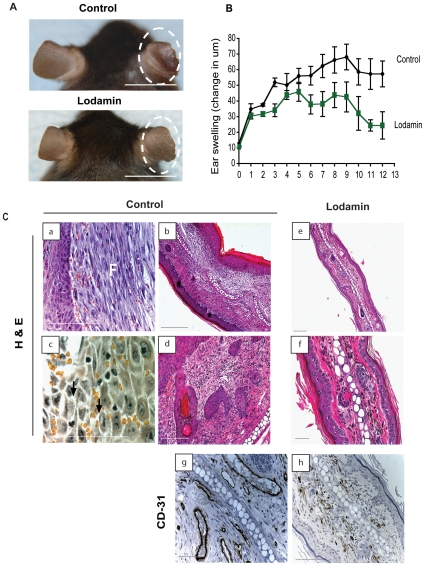
Lodamin inhibits angiogenesis, inflammation and edema in the DTH reaction.(A) Lodamin suppressed ear swelling in DTH reactions elicited by oxazolone, photos of representative ears of Lodamin treated or untreated mice are circled. Bar = 1 cm (B) Ear swelling is represented as change in thickness (in µm) compared to original ear thickness. Mice treated with Lodamin (white squares) showed a significant reduction in ear thickness compared to control mice (black squares). The differences were statistically significant from day 2 to day 12 post challenge, excluding day 5 (P<0.05). Data are presented as an average ±SEM, n = 5. (C) Immunohistological analysis of mouse ears post DTH reaction: H&E staining (a–f) and specific staining of endothelial cell marker CD-31 (g–h). In H&H staining, control ears exhibited an excessive inflammation and edema (a–d), including fibroblast proliferation (marked as F) and spongiosis pointed by arrows compared with Lodamin treated mice (e–f). Bar = 50µm.